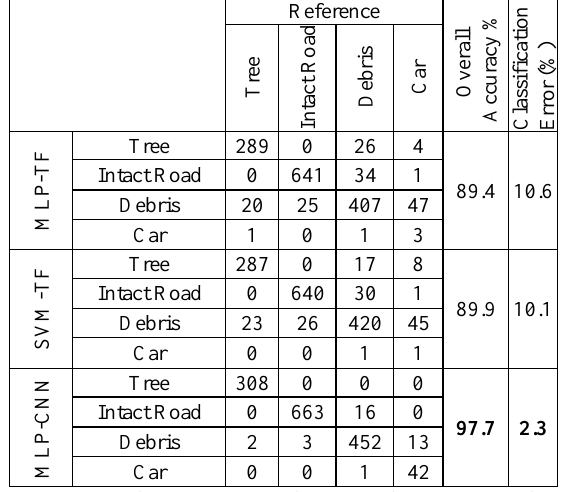
Table 1. Confusion Matrices of the classification results for different strategies.